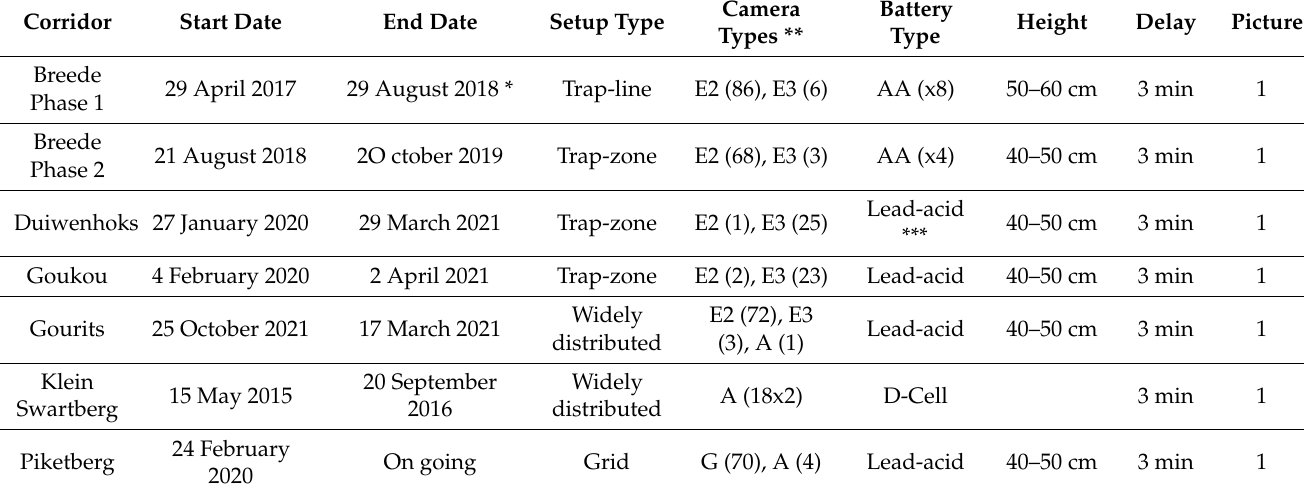
Table A3. Collated data regarding the setup periods and setup types, and camera-related information for all the projects. * One trap-line got removed on 15 February 2018. ** This indicates the total number of cameras of each type used and includes when a camera type swapped at a